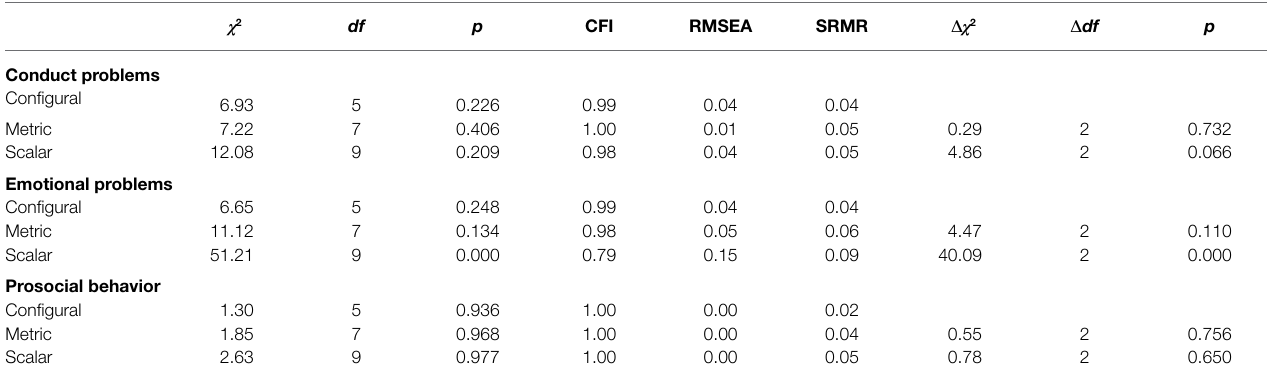
TABLE 2 | Model fit comparison of the three social-emotional outcomes outcomes for the examination of measurement invariance. χ 2 df p CFI RMSEA SRMR ∆ χ 2 ∆ df